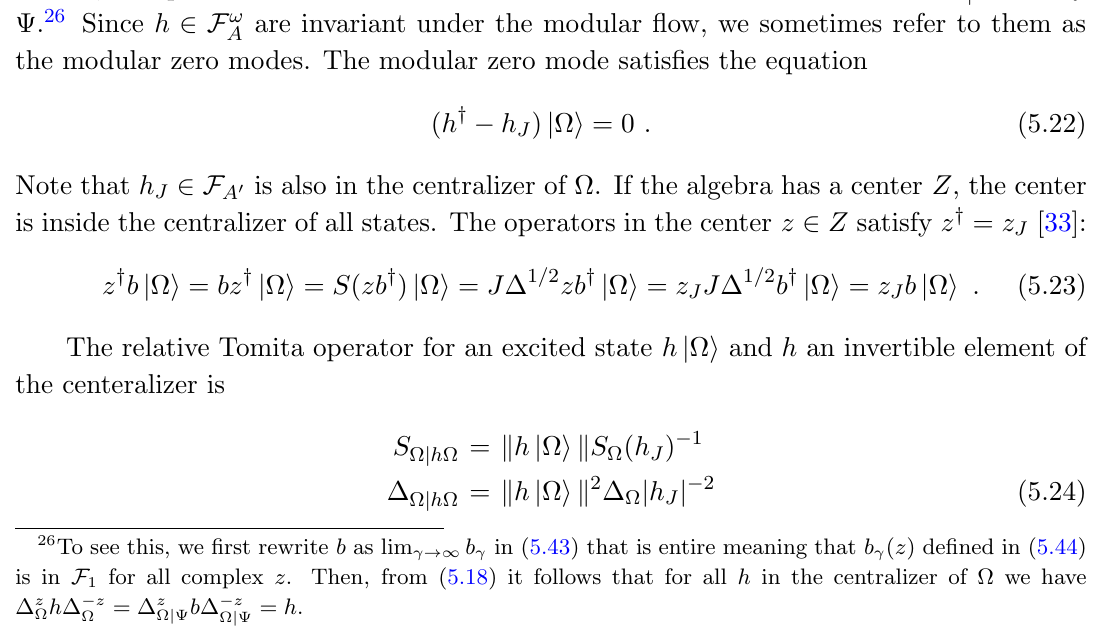
acts as the (cid:10) j (cid:9)